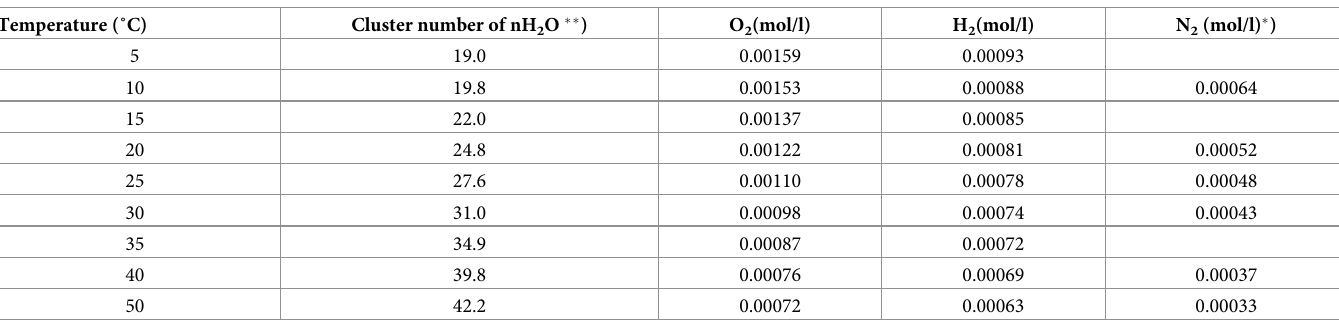
Table 1. Dissolved gas concentrations at specific temperatures (n =